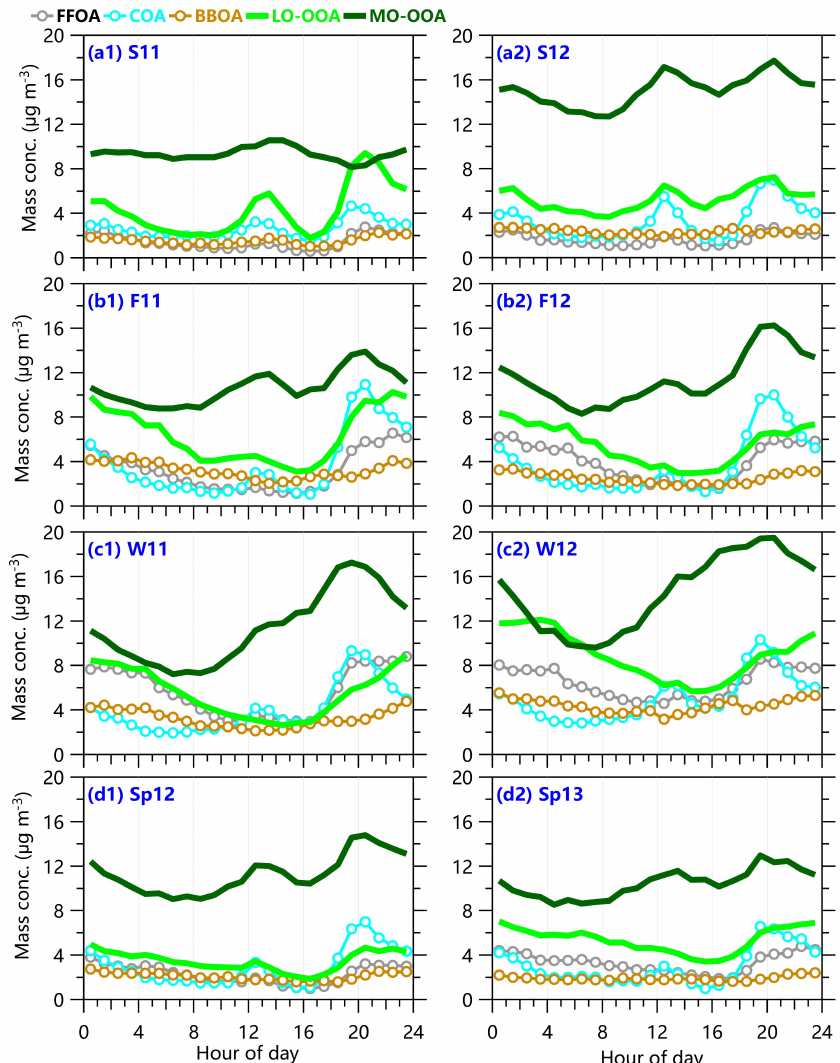
Figure 6. Average diurnal cycles of five OA factors during four seasons.